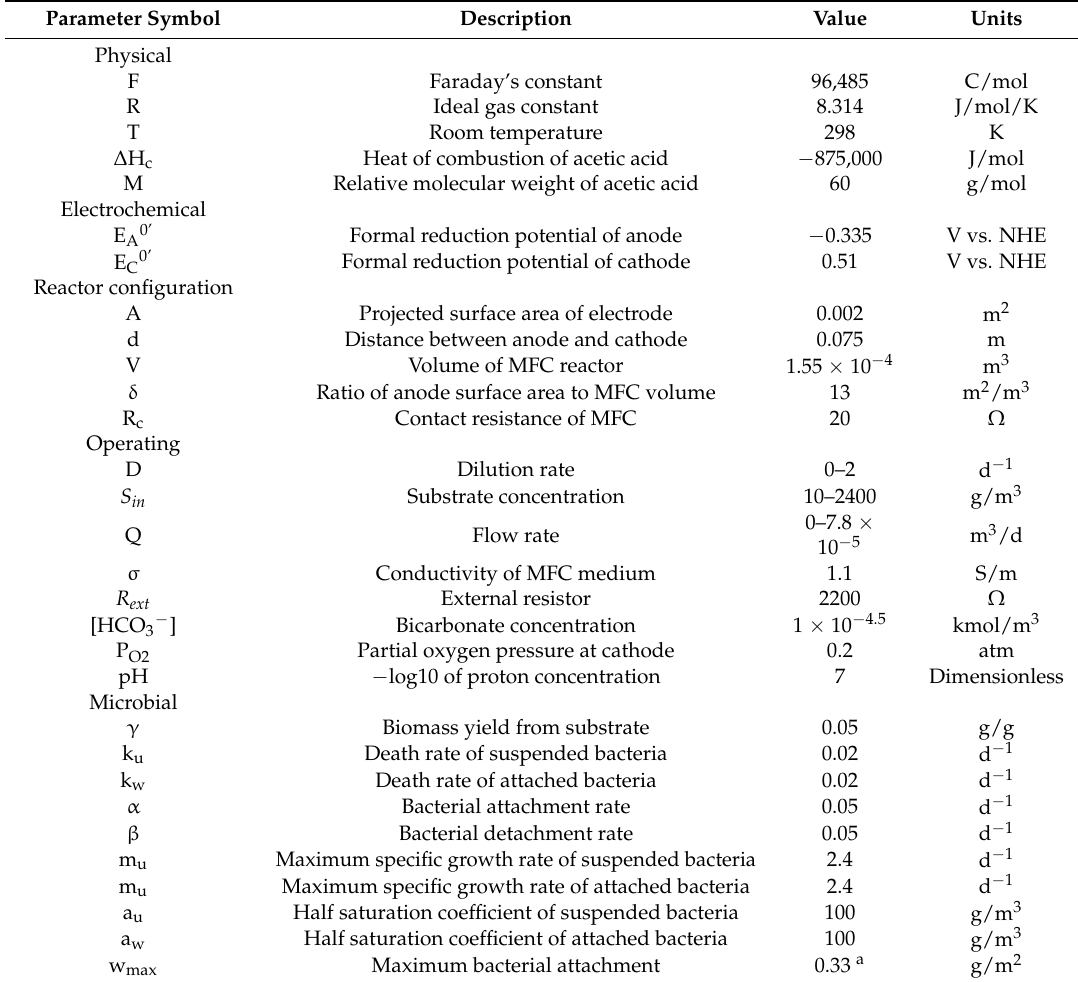
Table 1. Constants, and design and operating parameters of a microbial fuel cell system. NHE: the normal hydrogen